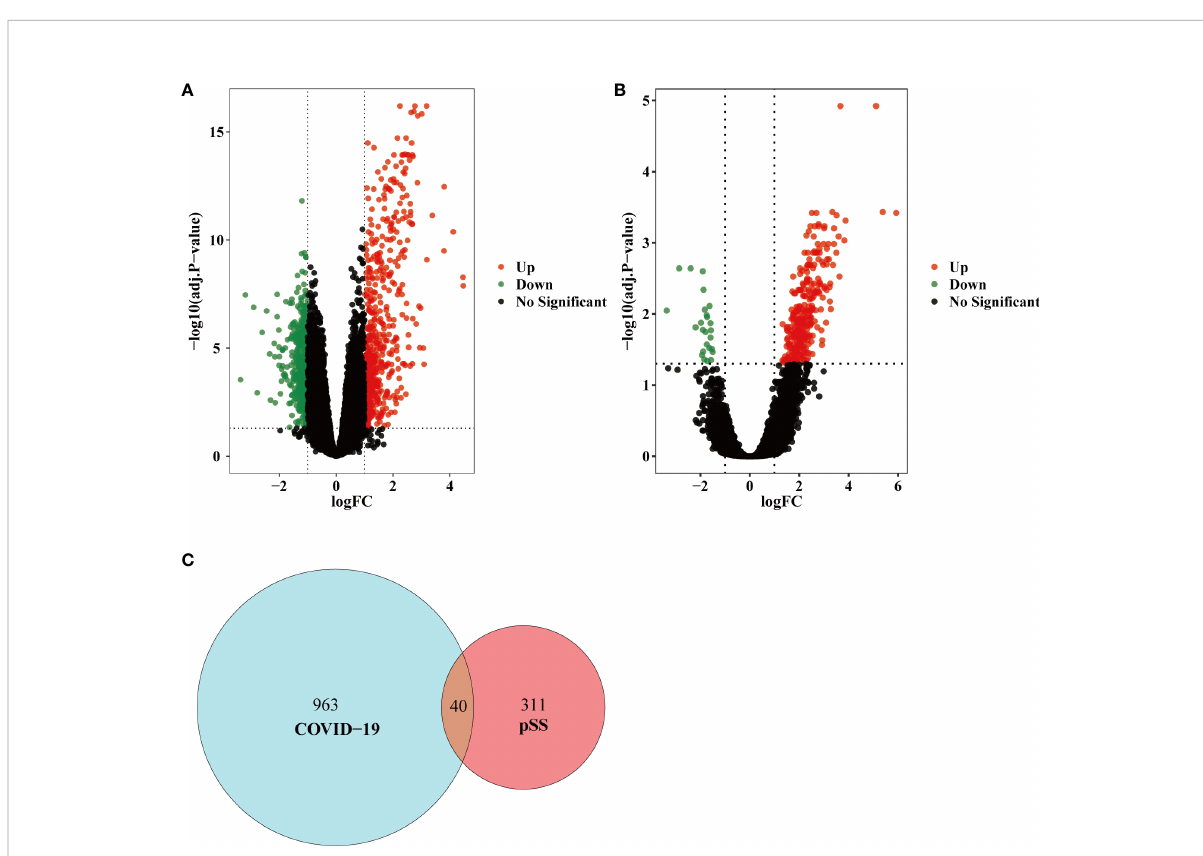
FIGURE 2 Volcano diagram and Venn diagram. (A) The volcano map of GSE157103. (B) The volcano map of GSE40611. Upregulated genes are colored in red; downregulated genes are colored in green. (C) The two datasets showed an overlap of 40 DEGs.